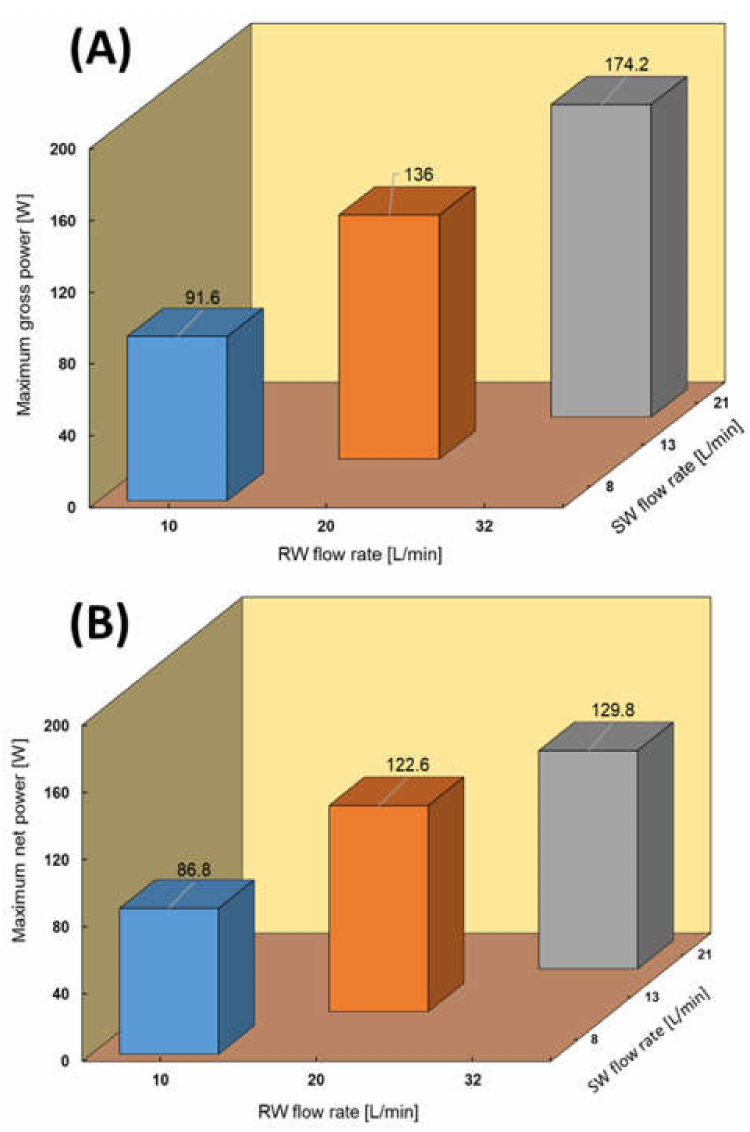
Figure 11. RED stack performance using model SW/RW feed solutions. ( A ) Maximum gross power density against feed flow rate, ( B ) Maximum net power against feed flow